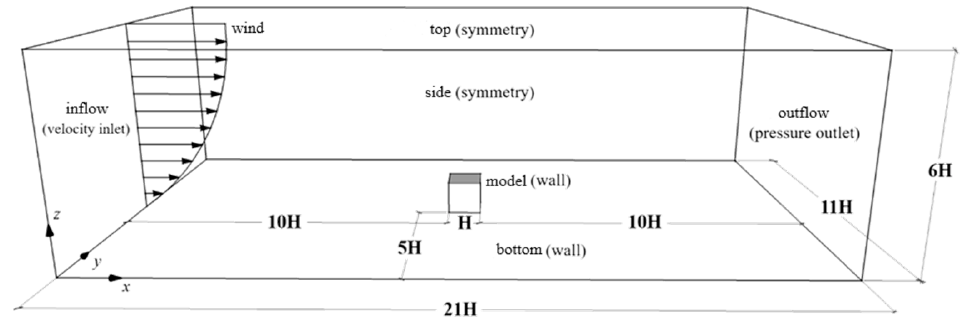
Figure 7. Settings of the computational domain.